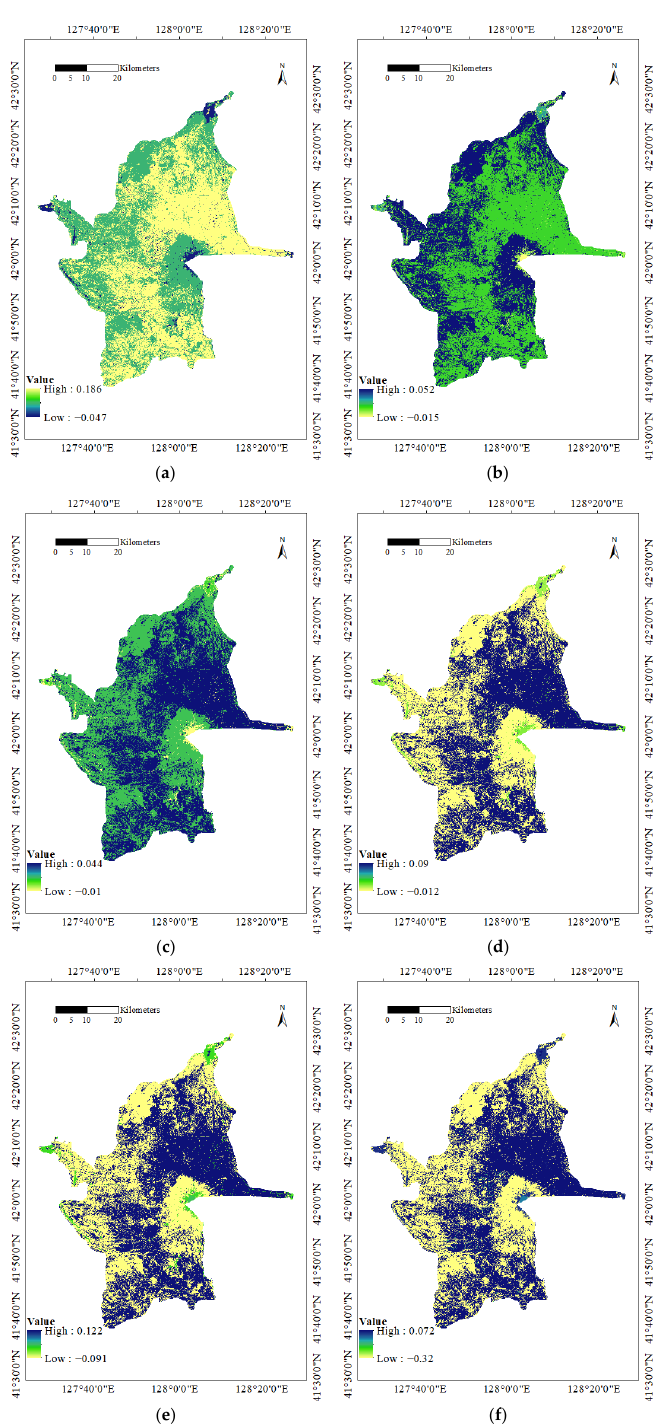
Figure 10. Changes of ISLI values in the Changbai Mountain Reserve from 1995 to 2025: ( a ) from 1995 to 2000, ( b ) from 2000 to 2005, ( c ) from 2005 to 2010, ( d ) from 2010 to 2015, ( e ) from 2015 to 2020, and ( f ) from 2020 to 2025.